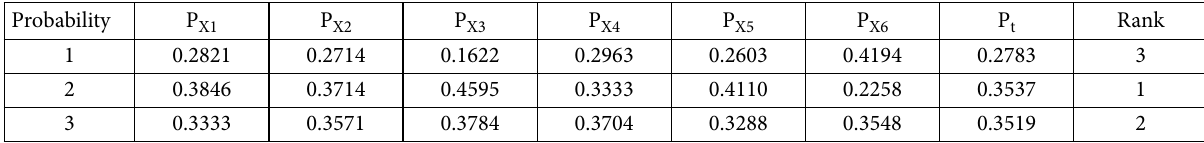
Table 6. Evaluated results for partial favorable probability, total favorable probability and ranking for project manager selection